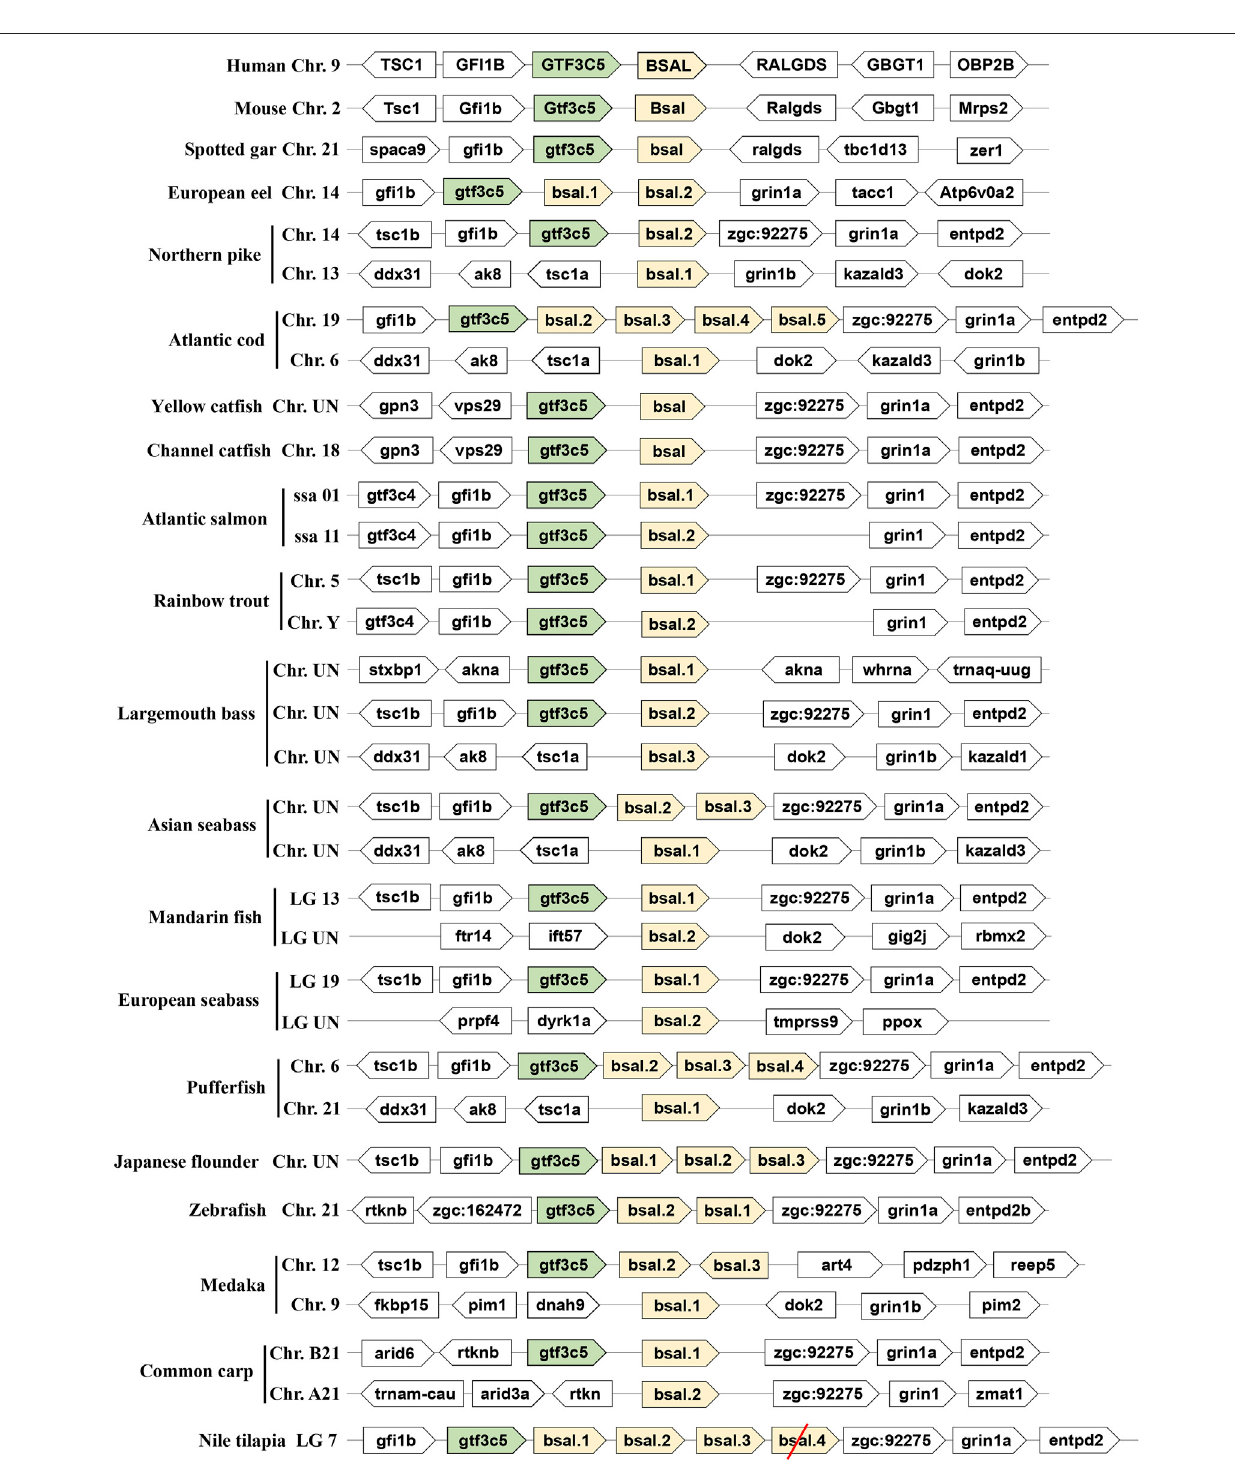
Frontiers in Genetics |